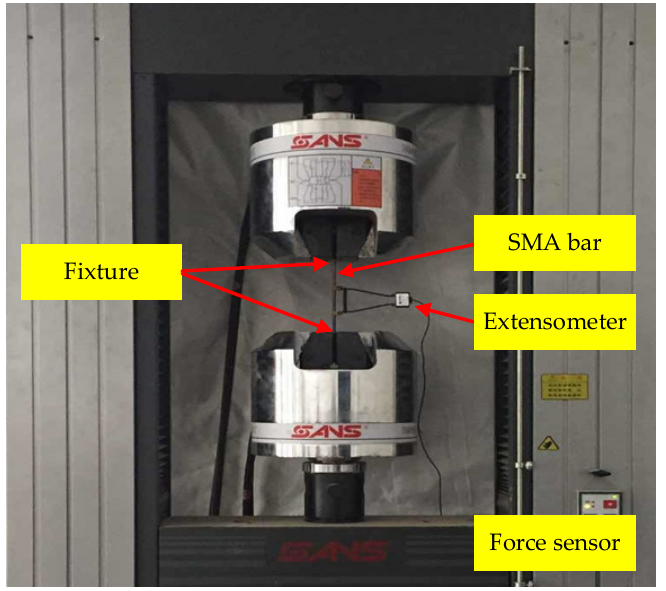
Figure 3. CMT electro-hydraulic servo universal material testing machine.